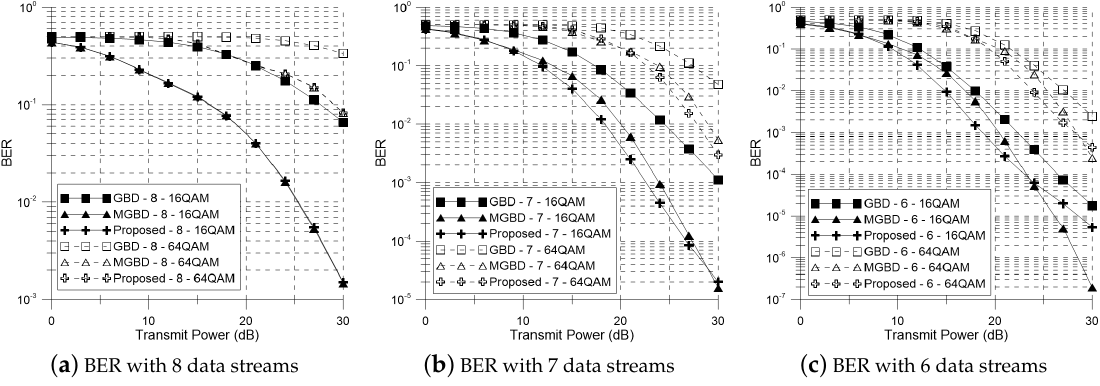
Figure 6. BER performance of GBD, MGBD and proposed scheme with N T = N R =